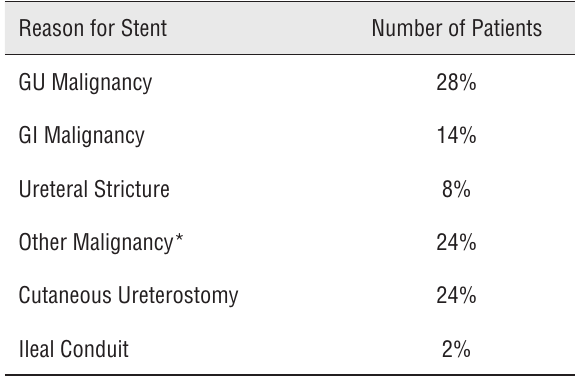
Table 1 - Indications for Stent